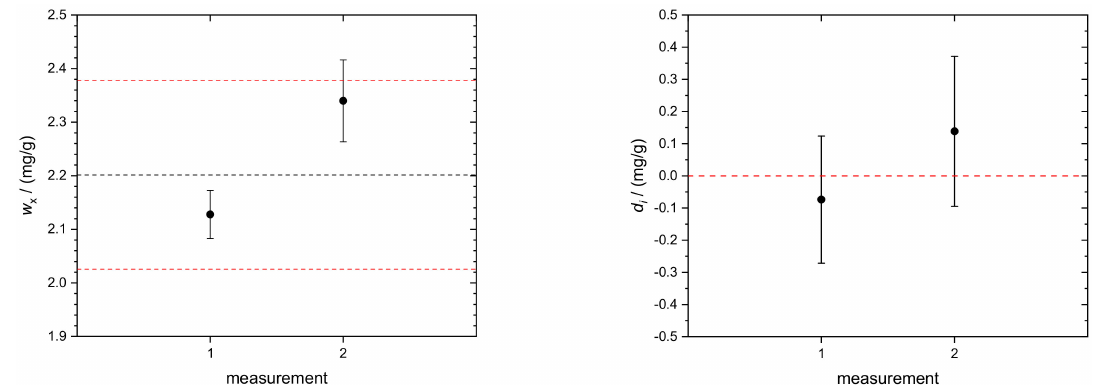
Figure 8. ( Left ) Black circles: mass fractions w x (TRF) of transferrin in human serum and the associated uncertainties ( k = 1); dashed black line: certified value of the Seronorm sample (for instrument, see Beckmann, AU). Data from the new combined IDMS/standard addition approach (this work). Red dashed lines: allowed target range according to Rili-BÄK [33]. ( Right ) Degrees of equivalence, d i , of the respective measurement results. Error bars indicate expanded uncertainties ( k = 2) associated with d i . All single results are consistent with the certified value since the respective uncertainties encompass the red dashed zero line.